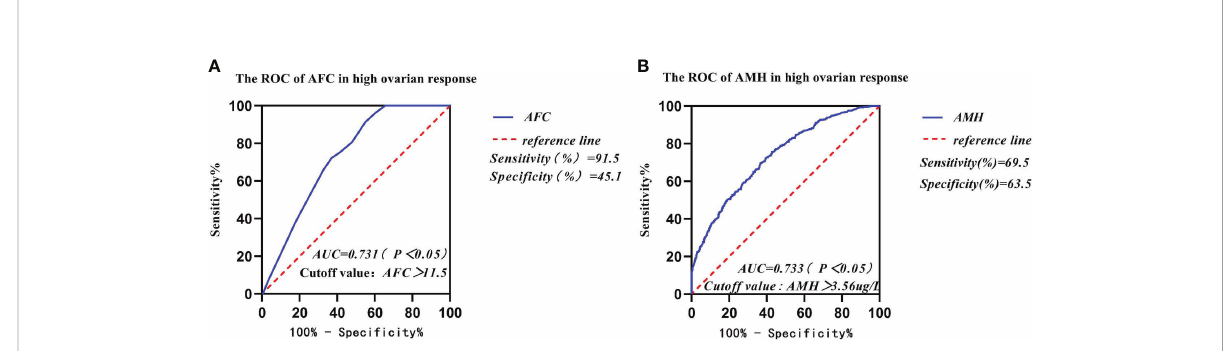
FIGURE 3 Comparison of prediction performance of Retrieved oocytes vs AFC, AMH, BMI, and age in the group of high ovarian response. (A) The ROC of AFC in high ovarian response; (B) The ROC of AMH in high ovarian